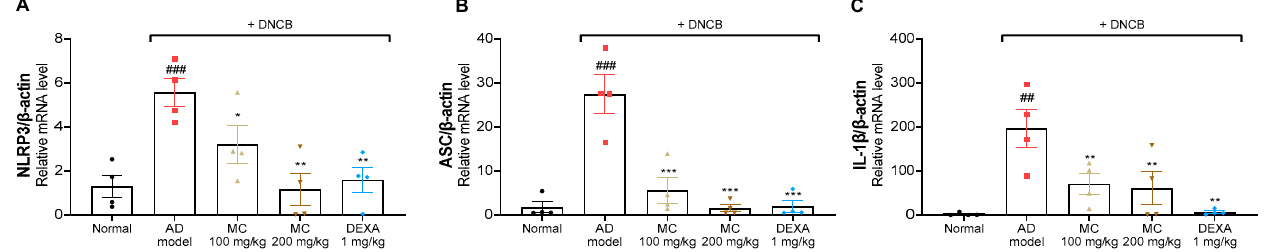
Figure 8. Effects of M. concanensis on the NLRP3 inflammasome in DNCB-induced AD lesional ear tissues. The mRNA levels of NLRP3 ( A ), ASC ( B ) and IL-1 β ( C ) in DNCB-induced lesional ear tissue were measured by RT ‒ qPCR (n = 4). The data presented are the mean of three independent determinations and indicate the mean ± S.E.M. ## p < 0.01 and ### p < 0.001 versus Normal. * p < 0.05, ** p < 0.01 and *** p < 0.001 versus the only DNCB-treated group. AD model; only DNCB-treated group, MC 100 mg/kg + DNCB; DNCB-induced mice administered with 100 mg/kg of M. concanensis , MC 200 mg/kg + DNCB; DNCB-induced mice administered with 200 mg/kg of M. concanensis , DEXA 1 mg/kg + DNCB; DNCB-induced mice administered with 1 mg/kg of dexamethasone.